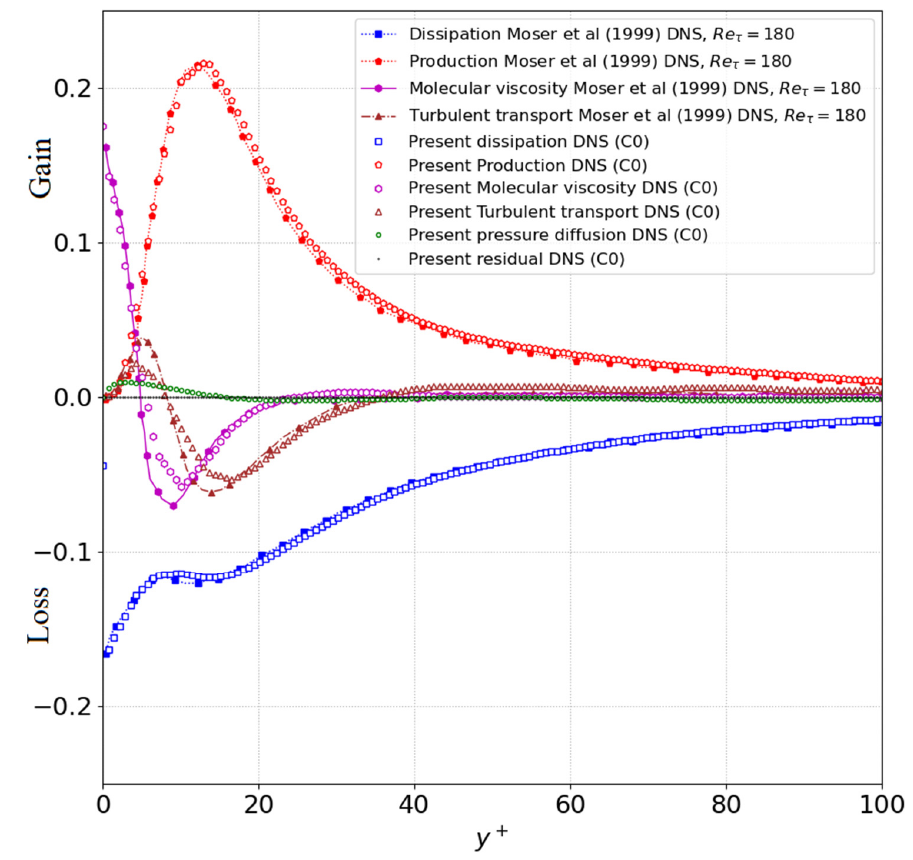
Figure 7. Comparison of the turbulent kinetic energy budget with DNS results by Moser et al. [16] in terms of the production, dissipation, turbulent diffusion, molecular diffusion, and pressure dif- fusion.